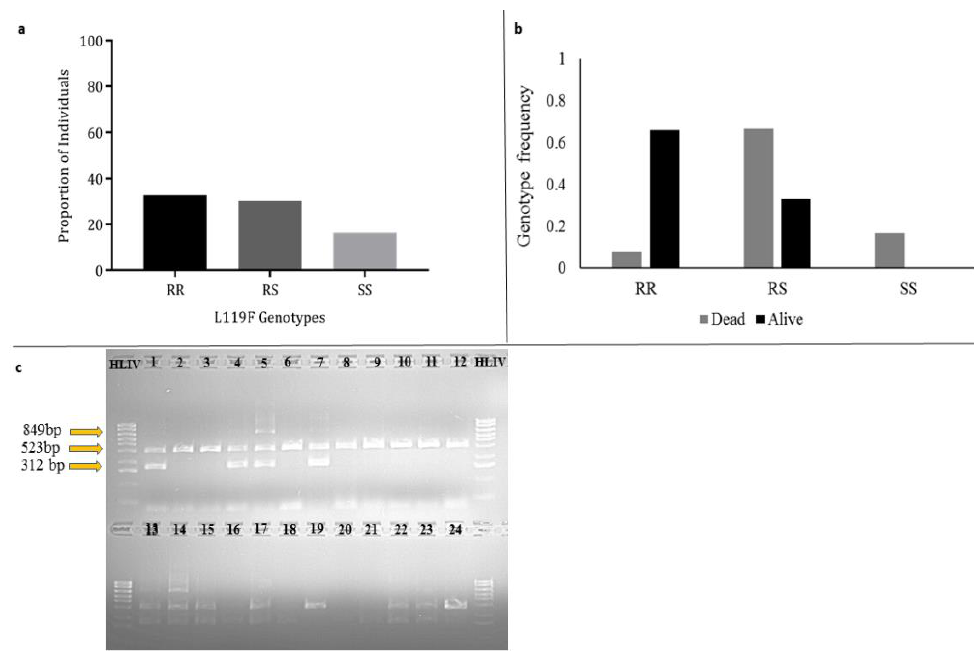
Figure 3. Genotyping of L119F GSTe2 mutation. ( a ): distribution of the 119F mutation among the 44 randomly selected F 0 females; ( b ): the 119F mutation genotype for 12 each of DDT-alive and -dead F 1 females, RR = homozygote resistant, RS = heterozygote resistant, and SS = susceptible; ( c ): agarose-gel showing the L119F genotype distribution from allele-specific PCR (AS-PCR), top panel: 12 DDT-alive F 1 females (2, 3, 6, and 8–12 are RR, 1, 4, 5 and 7 are RS), bottom panel: 12 DDT-dead F 1 females (13,